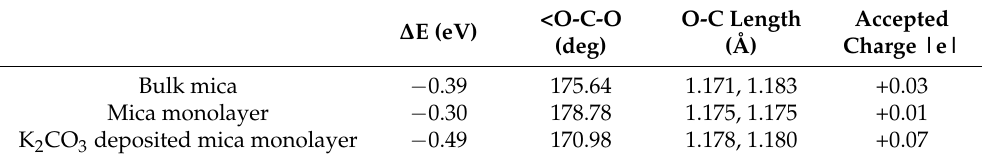
Figure 7. Configuration of adsorbed CO 2 on ( a ) bulk mica, ( b ) a mica monolayer and ( c ) K 2 CO 3 deposited mica monolayer. Table 3. CO 2 adsorption energy ∆ E and structural data of adsorbed CO 2 for studied mica